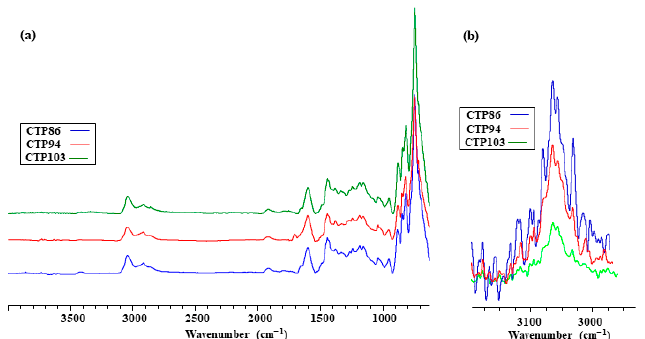
Figure 3. ATR spectra of CTPs ( a ) and fragments of FT-IR spectra of their volatile products of pyrolysis emitted at a temperature of 300 ◦ C ( b